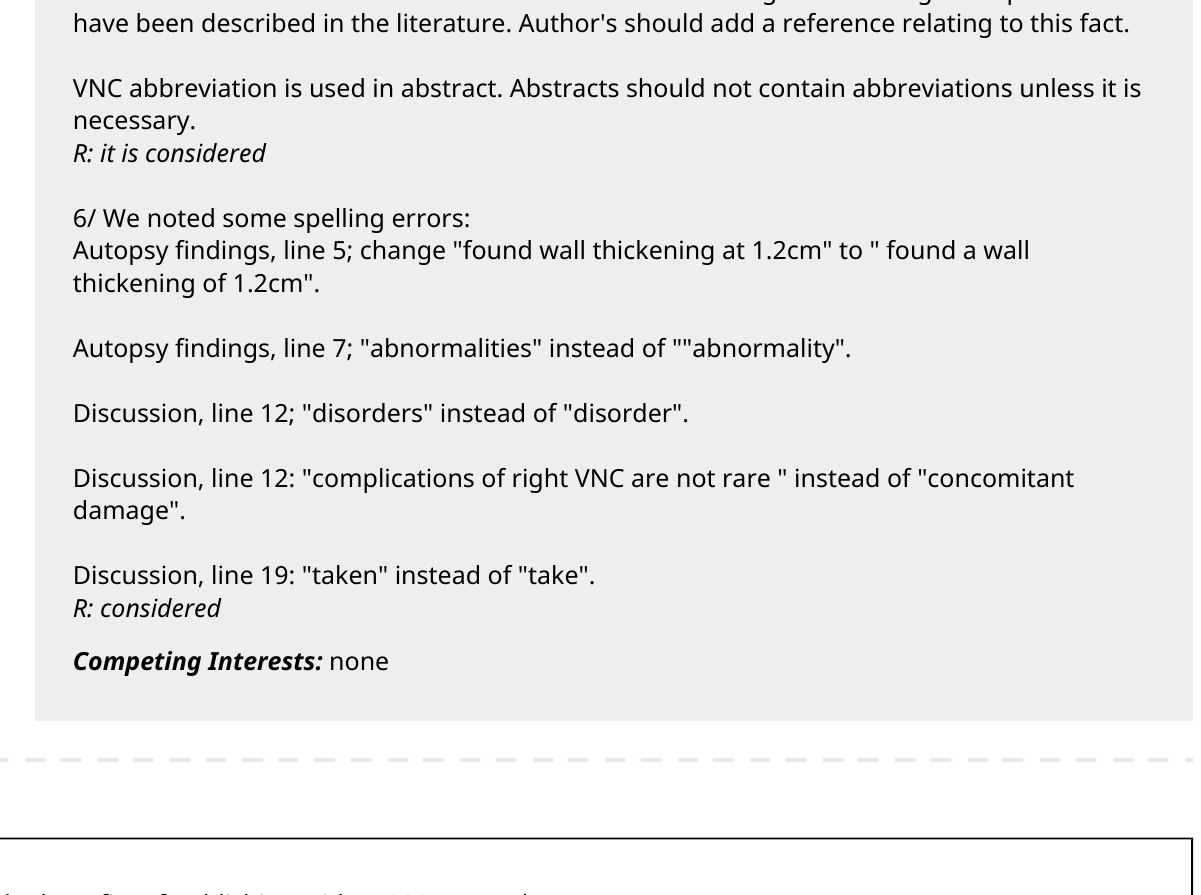
Figure 2: it would be more accurate to mention: non compacted left